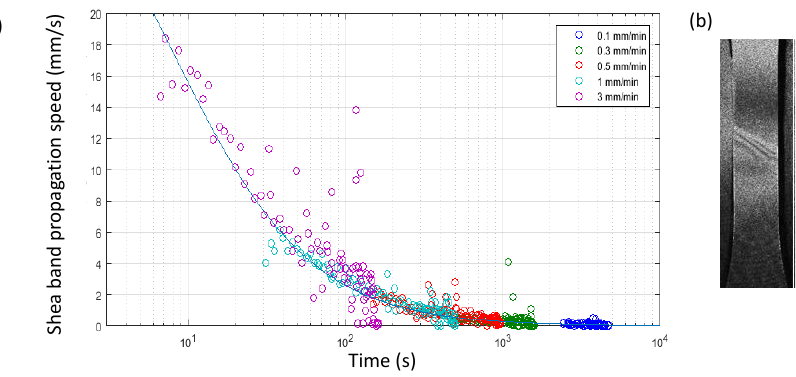
Figure 8. ( a ) Shear band propagation speed as a function of time for different pulling rates. ( b ) Typical Electronic Speckle-Pattern Interferometry (ESPI) image showing a shear